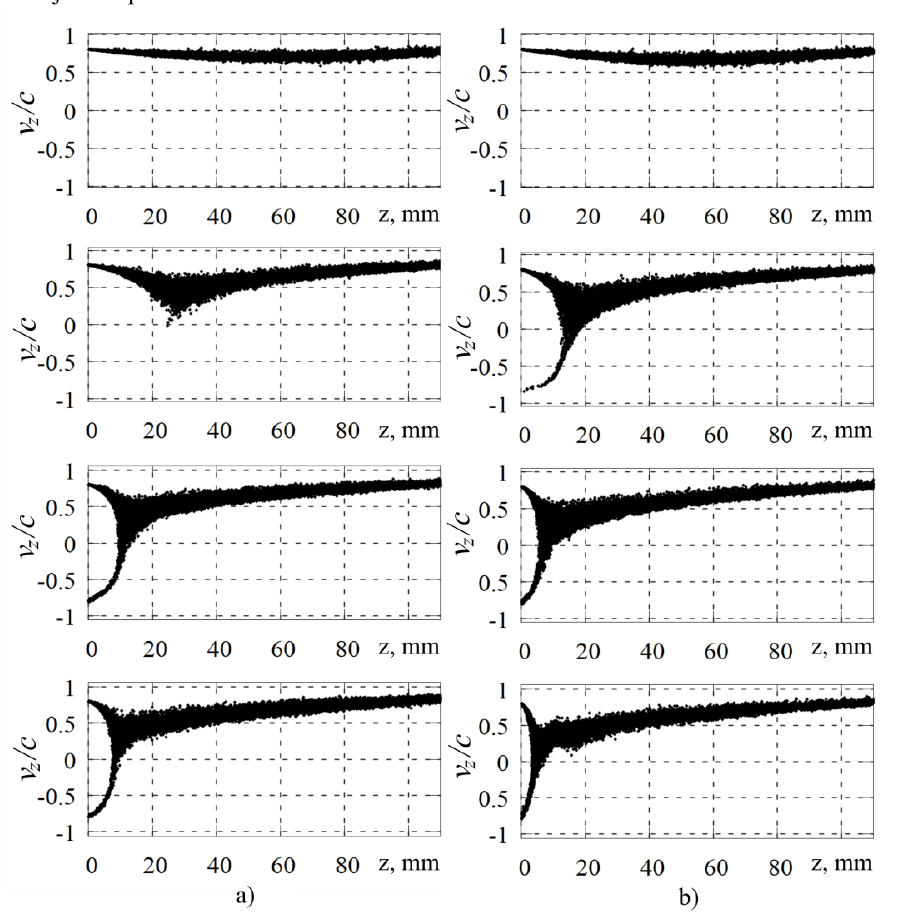
Fig. 4. Projections of the phase space of the electron beam in the (v z , z) plane with increasing beam current a) without taking into account the image field b) with the images. System parameters: v = 0.8 c, B = 1 T, r = 5.48 mm, N = 30, Δt = 1 ps , t = 600 ps. The current takes the values I = 1 kA, 2 kA, 3 kA, 5 kA (from top to